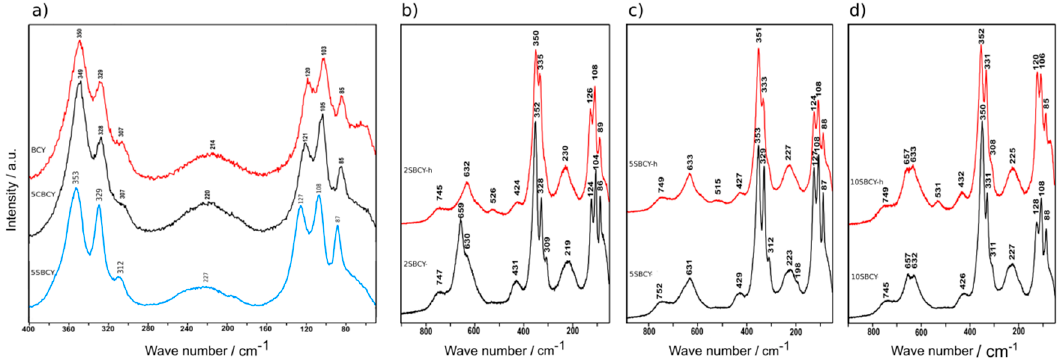
Figure 4. Raman spectra recorded for BCY ( a ), Ba 0.98 Sr 0.02 Ce 0.9 Y 0.1 O 3 − δ (2SBCY) ( b ), 5SBCY ( c ), and Ba 0.9 Sr 0.1 Ce 0.9 Y 0.1 O 3 − δ (10SBCY) ( d ) samples before and after additional heating (h) in 5 vol.% H 2 O-Ar at 550 °C for 100 h.